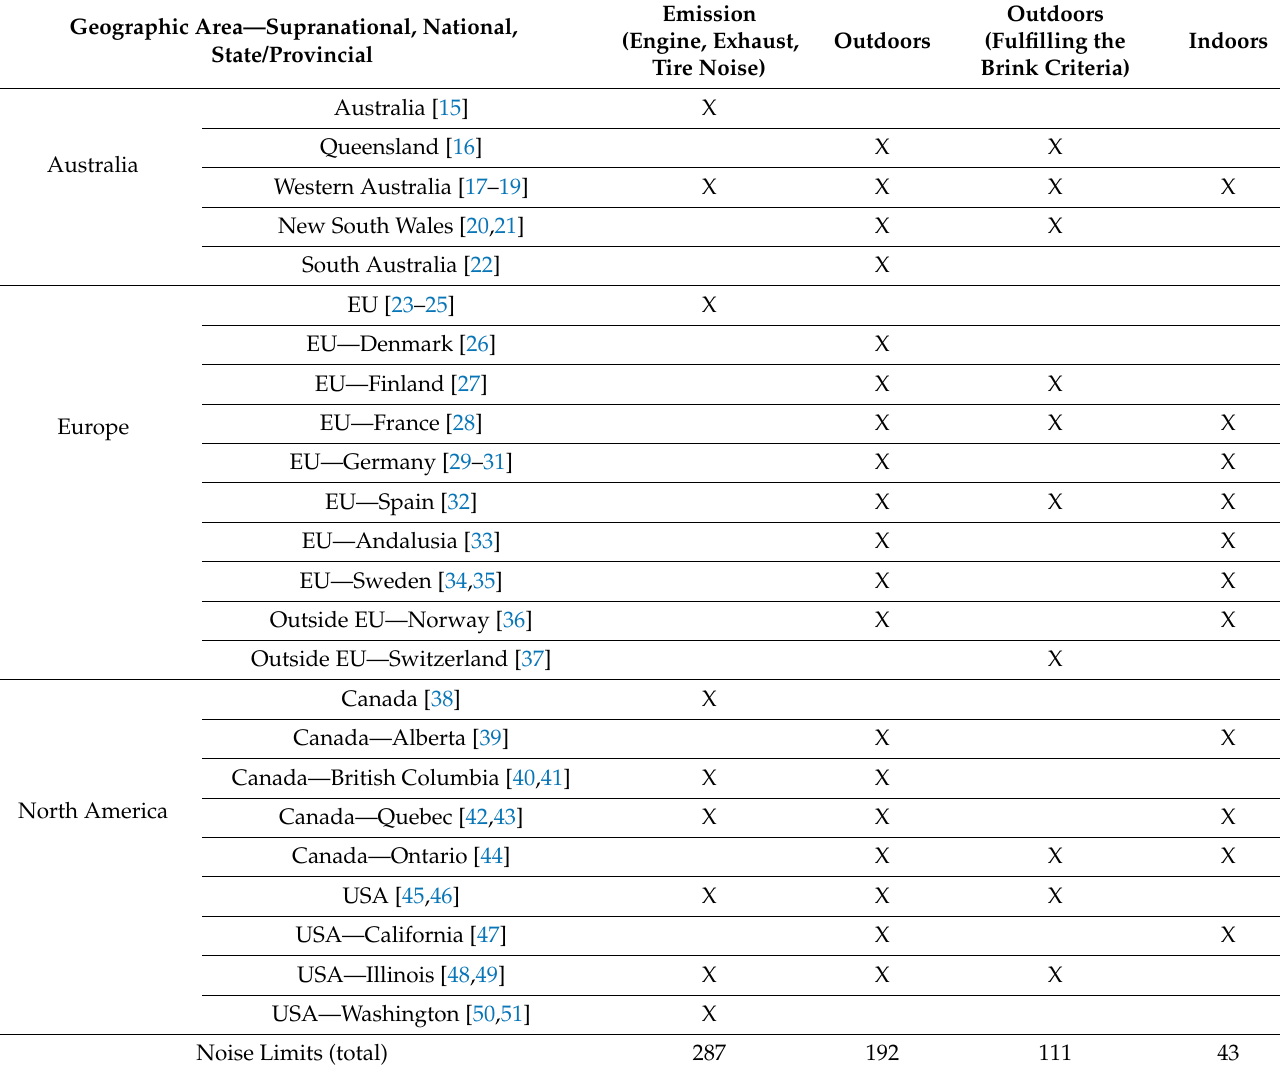
Table 3. Definition of acoustic indicators identified in noise policies and